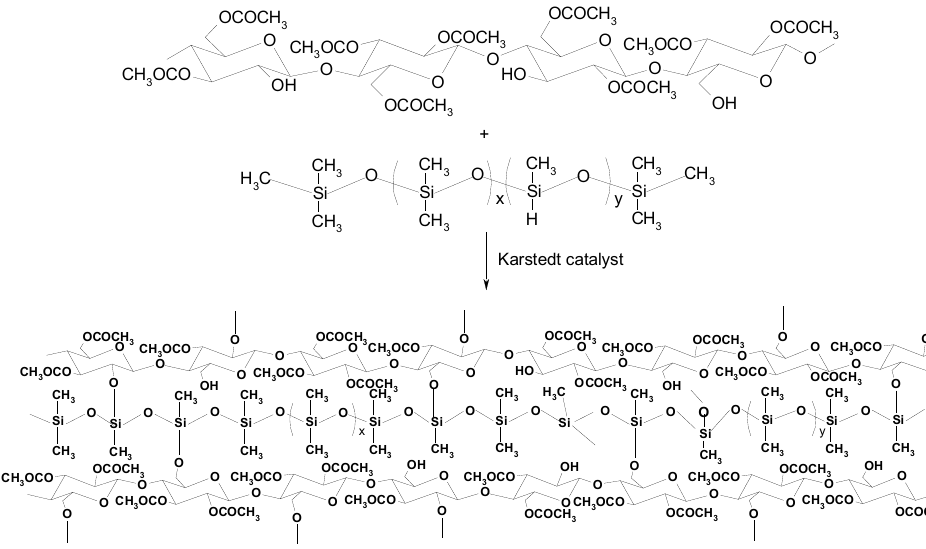
Figure 6. Cellulose silylation and the subsequent regeneration using acid vapor. Reproduced from [47] with permission from Springer and Copyright Clearance Center, 2010.